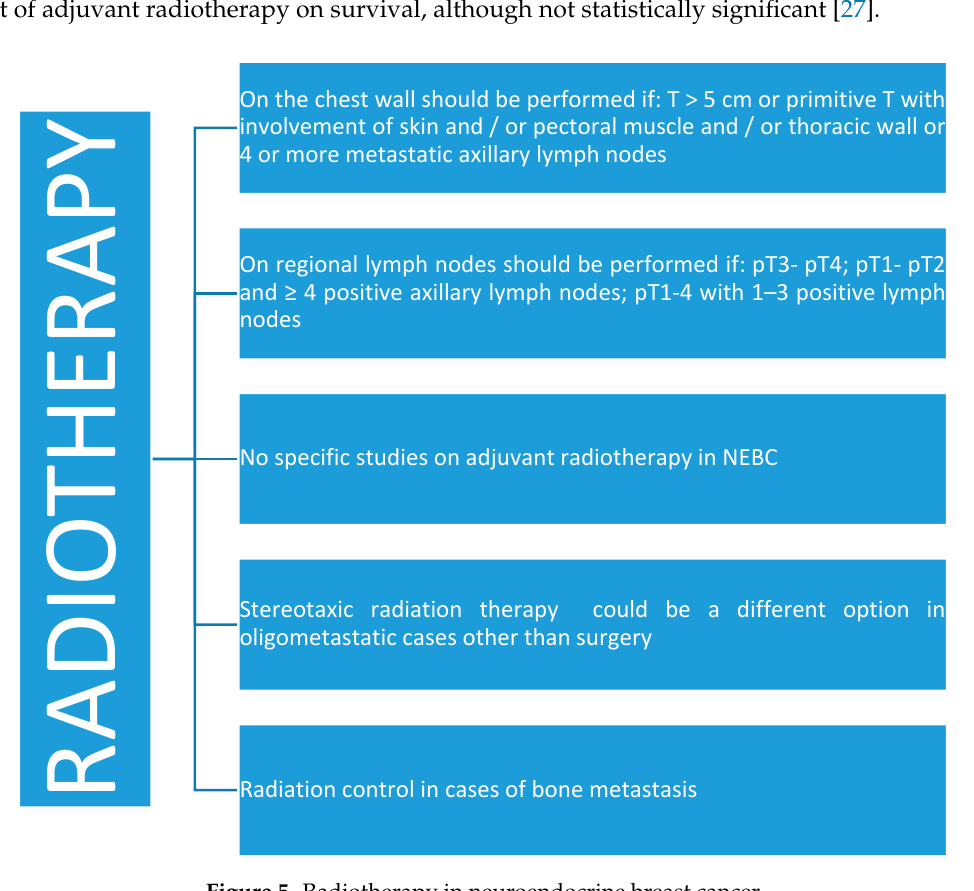
Figure 5. Radiotherapy in neuroendocrine breast cancer